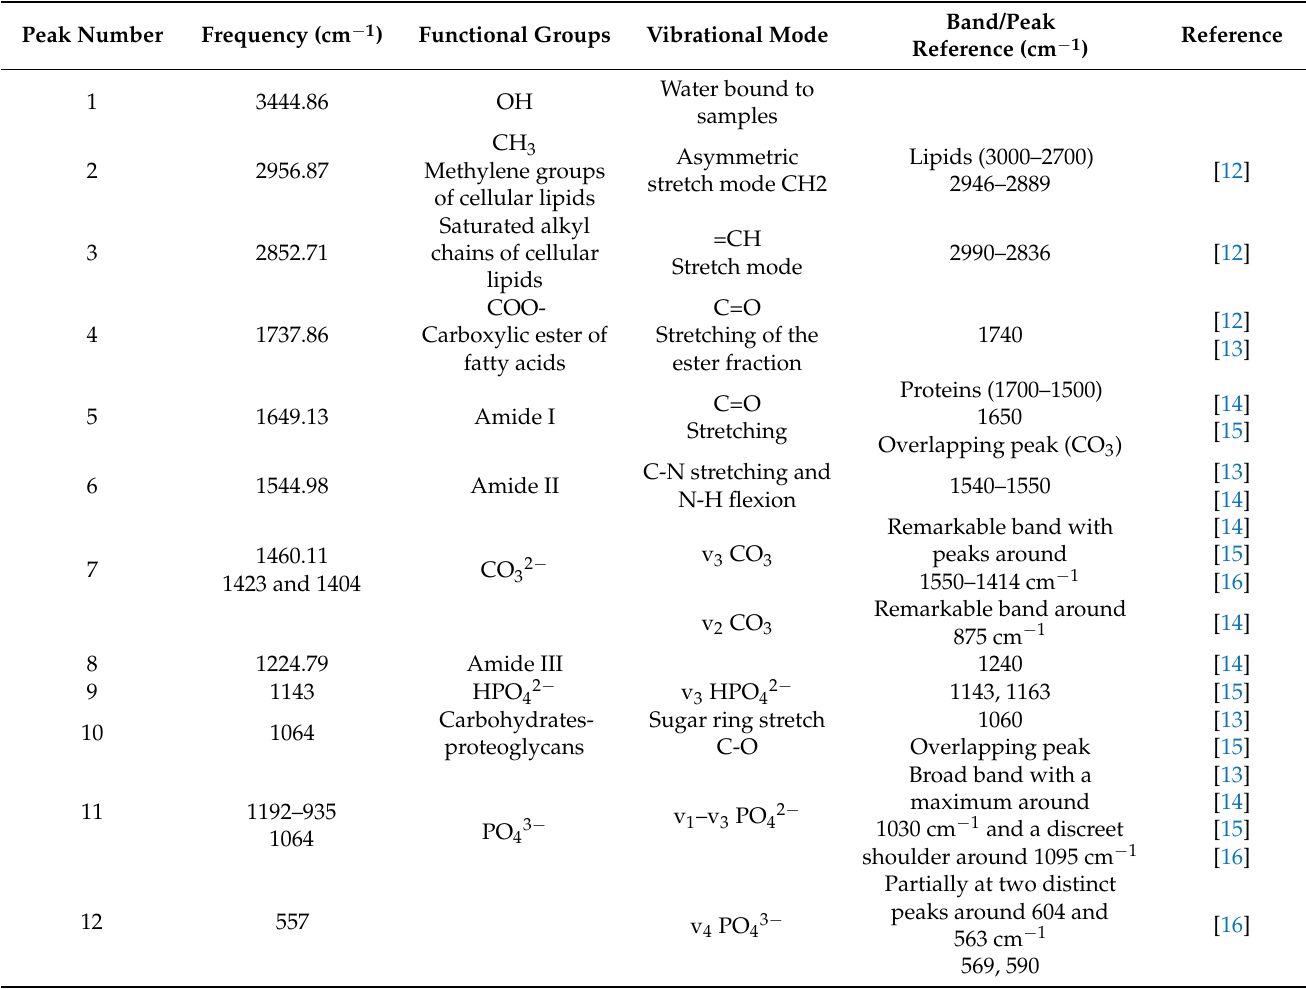
Table 2. Relevant peaks of the FTIR spectra of hGFs